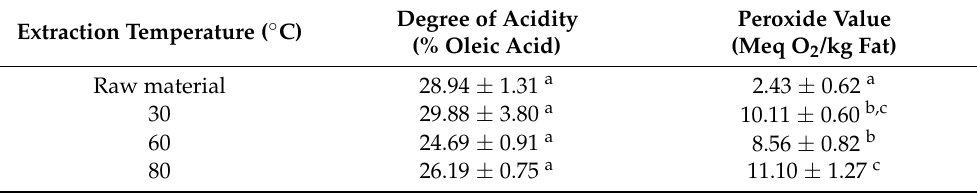
Mean of three measurements ± standard deviation. Different letters ( a , b or c ) in each column, show significant differences ( p < 0.05). The degree of acidity is a measure of the amount of free fatty acids in the oil